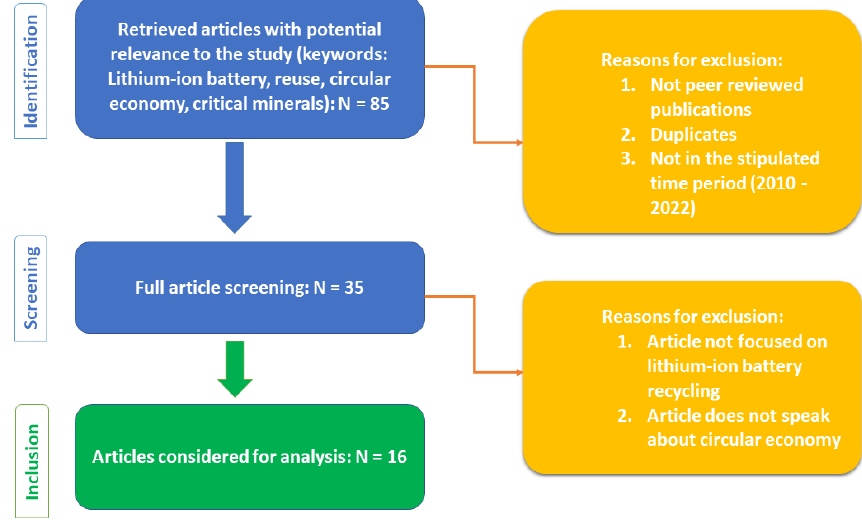
Figure 2. Flowchart for selecting articles. Table 3. Number of papers in academic